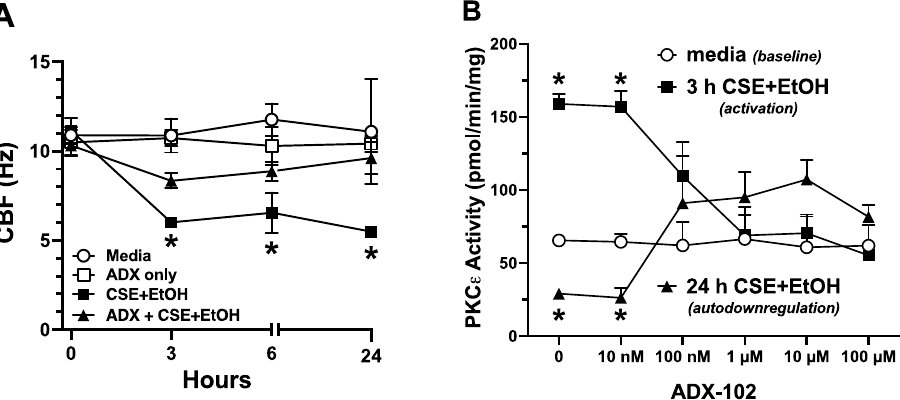
Figure 4. ADX-102 and tracheal epithelial ciliated cell protein kinase C epsilon mediated cilia beating. Ciliated MTECs were treated with or without the combination of 5% cigarette smoke extract (CSE) and 50 mM ethanol (EtOH) in the presence or absence of 10 µM ADX-102, and cilia beat frequency (CBF) was measured from 0–24 h ( A ). Baseline control consisted of DMEM with 10% serum (Media). * p < 0.05 ADX vs. no ADX in the presence of CSE + EtOH at 3, 6, and 24 h. Dose–response (0–100 µM) for ADX-102 on combined CSE and EtOH stimulated (3 h) and autodownregulated (24 h) protein kinase C epsilon (PKC ε ). * p < 0.01 vs. medium control. Bars represent SEM of n = 6, each with three replicates ( B ).